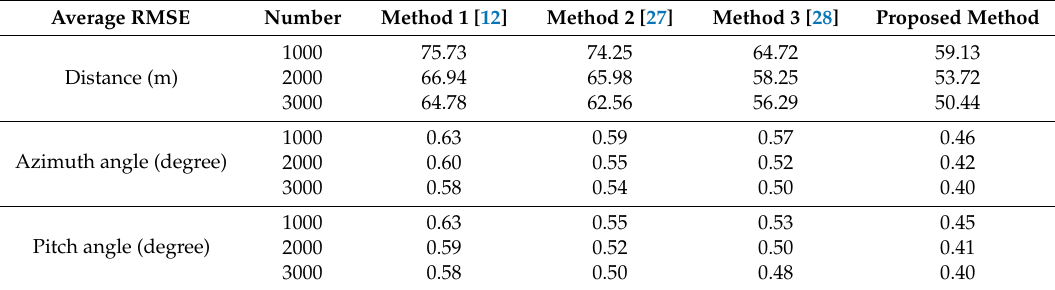
Table 12. The average RMSE for varying the number of track points among four methods.